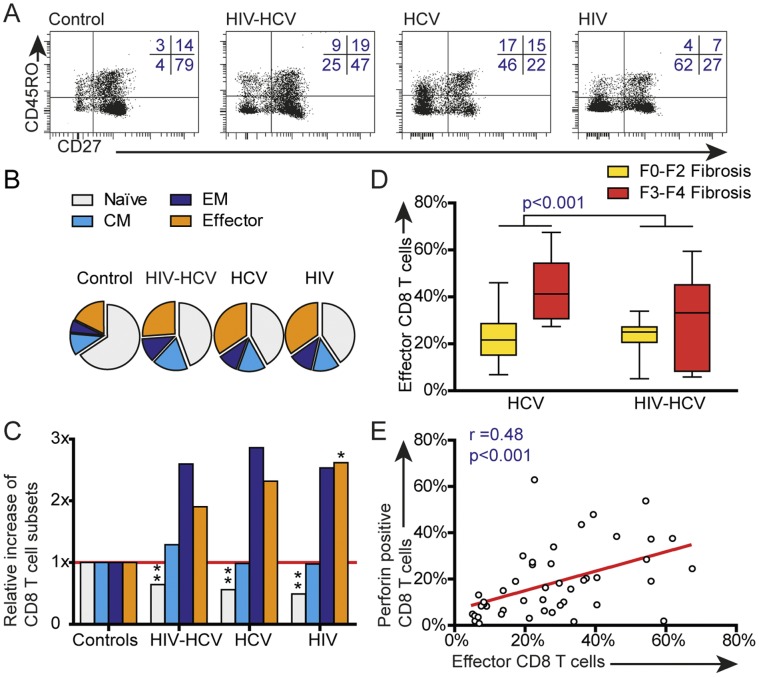
Changes in CD8+ effector and memory phenotype in all patients and healthy controls.A: representative plots of a healthy control, HIV-HCV coinfected, HCV monoinfected and HIV- mono patient showing naïve (right lower quadrant), central memory (right upper quadrant), effector memory (left upper quadrant) and effector (left lower quadrant) CD8+ T-cells by CD27 and CD45RO staining. B: pie charts of mean percentages of naïve (light grey), central memory (CM; light blue), effector memory (EM; dark blue) and effector (orange) CD8+ T-cells in 42 patients and 3 healthy controls. C: relative increase of median percentages of memory subsets compared to healthy controls. D: box plot showing percentages of effector CD8+ T-cells in HCV-monoinfected (left) or HIV/HCV-coinfected patients (right) with fibrosis scores F0–F2 (yellow) versus F3–F4 (red). The depicted p-value was calculated with two way ANOVA and indicates statistical significant difference in percentages of effector CD8+ T cells in F0–F2 fibrosis compared to F3–F4 fibrosis, independent of coinfection with HIV. Liver fibrosis was assessed with Fibroscan in 74% of HCV monoinfected patients and 71% of HIV/HCV coinfected patients. E: correlation of staining for perforin (Y-axis) with effector phenotype (X-axis) in CD8+ T-cells. Box-plots show median, quartiles and range. Line represents linear regression. P-values are depicted as: * (<0.05) and ** (p-value <0.01).